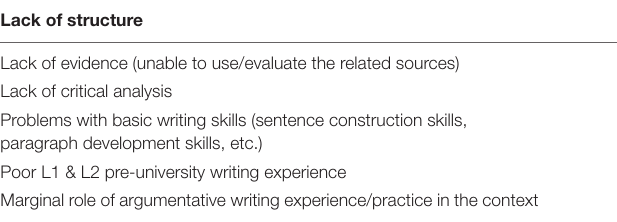
TABLE 3 | Teachers’ views on students’ problems with argumentative writing. Lack of structure Lack of evidence (unable to use/evaluate the related sources) Lack of critical